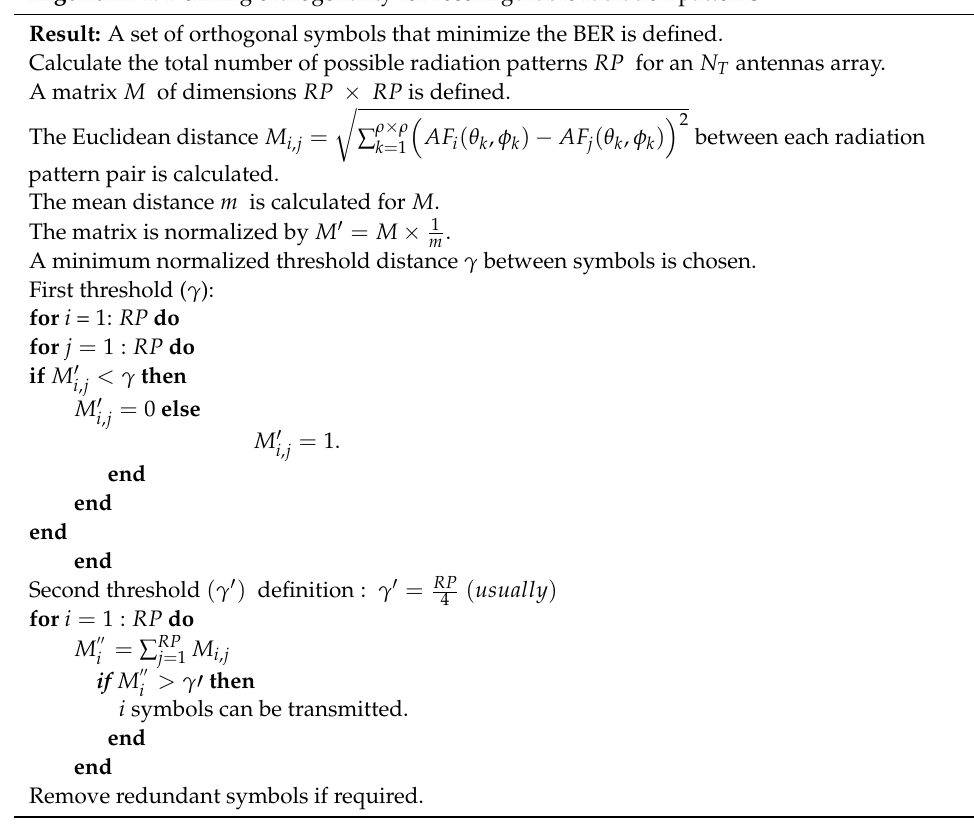
Algorithm 1: Defining orthogonality for reconfigurable radiation